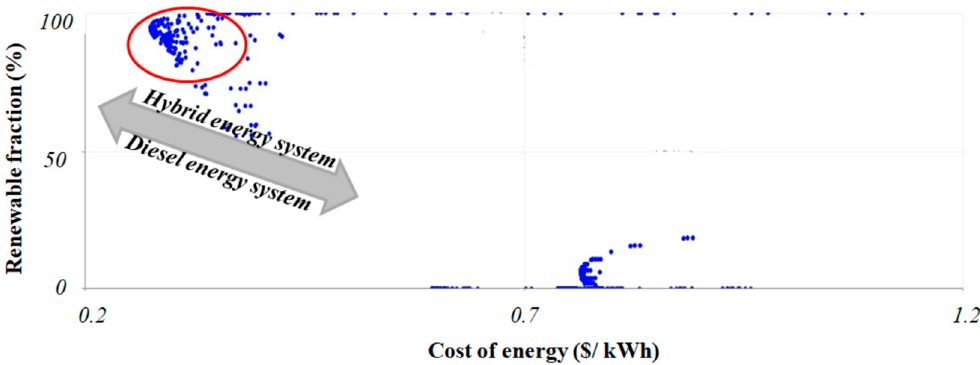
Figure 20. Optimization plot between the cost of energy and a renewable fraction (project lifetime of 25 years).